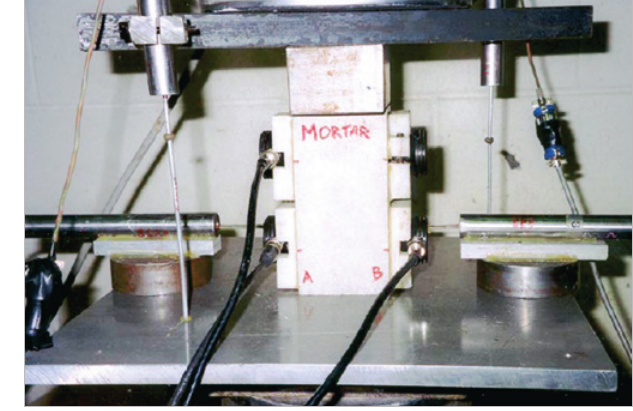
Experimental setup: after a steady state was achieved, side A had a temperature of 50ºC and side B a temperature of 120ºC. The steady state was kept for one hour and then the specimen was cooled down to room temperature for the application of the mechanical loading and ultrasonic